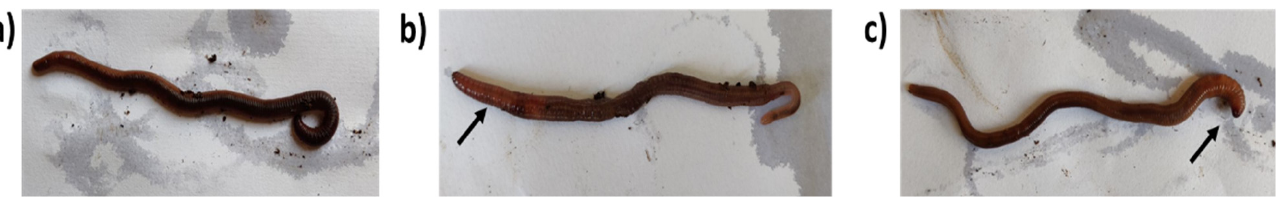
Figure 7. Phenotypic changes observed in earthworms exposed to silver nanoparticles. ( a ) control; ( b ) exposed to 10 µg; ( c ) exposed to 20 µg (Black arrow indicates the brownish pink changes). Table 1. Phenotypic changes observed in earthworms exposed to silver nanoparticles synthesized using Bauhinia purpurea gum.